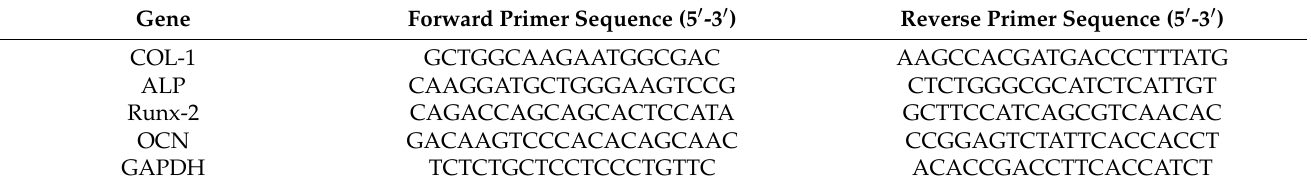
Table 1. Primers Used in